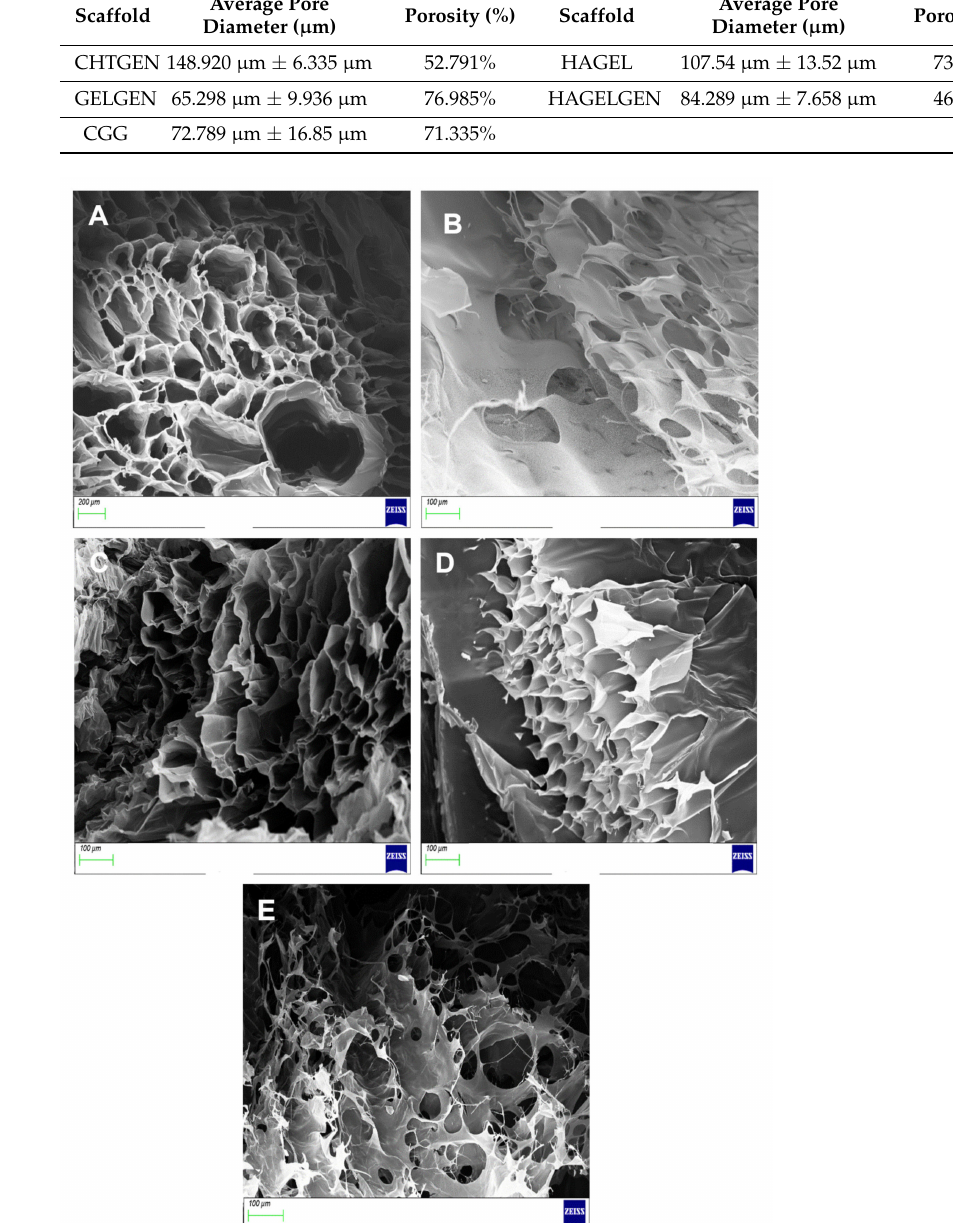
Table 2. Calculated average pore diameters and porosity of each scaffold (n = 10). Scaffold